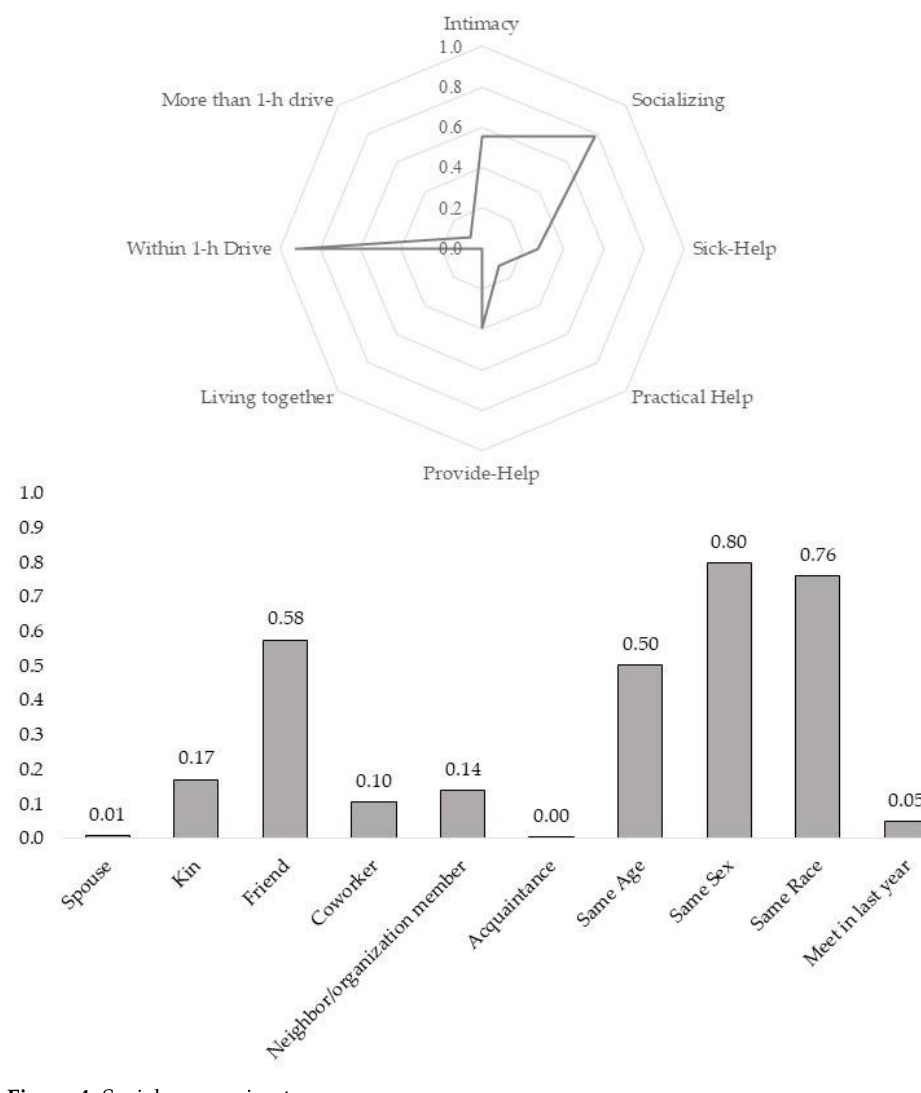
Figure 4. Social companion type.